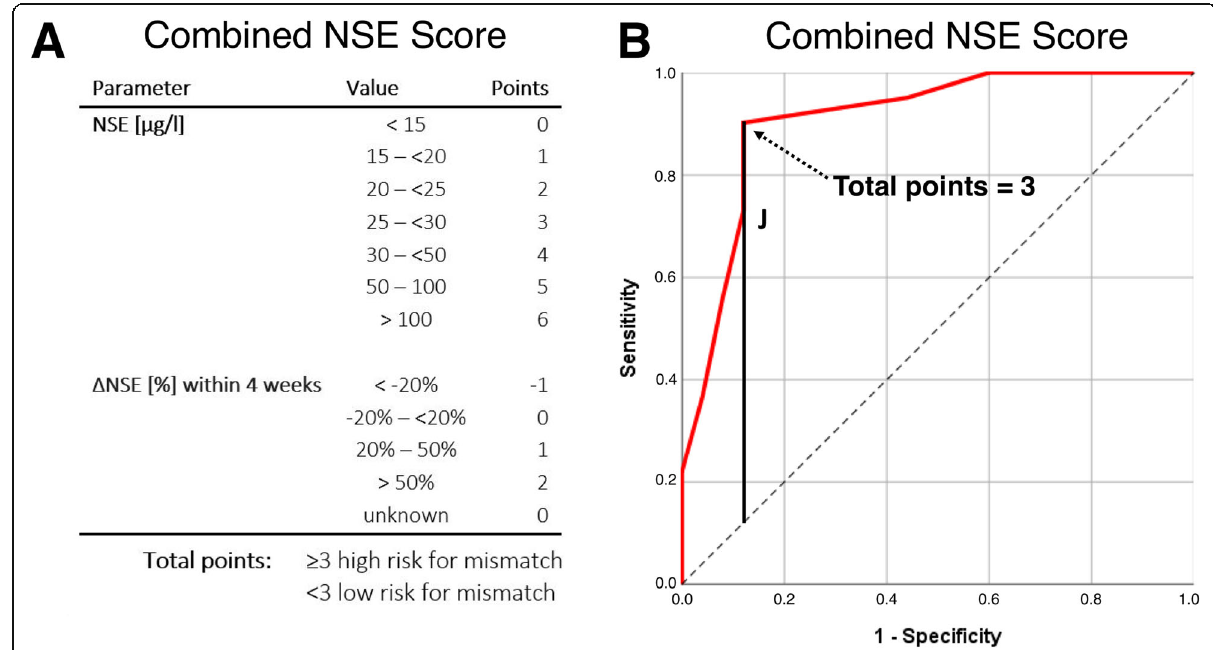
Fig. 6 Combined NSE Score ( a ) and ROC curve for mismatch prediction by the score ( b ) with maximum value of the Youden index ( J